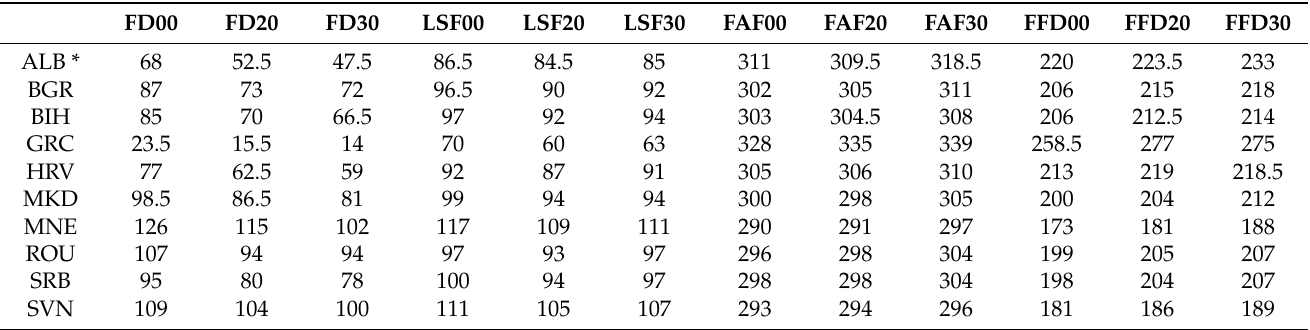
Table 1. The median values of the frost indicators (FD, LSF, FAF, FFD) per country for the three time horizons 2000 (00), 2020 (20) and 2030 (30).